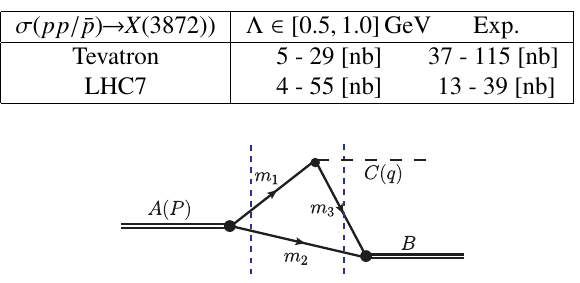
Table 2. Integrated cross sections (in units of nb) for pp / ¯ p → X (3872) compared to experimental measurements by CDF [69] and CMS [70].